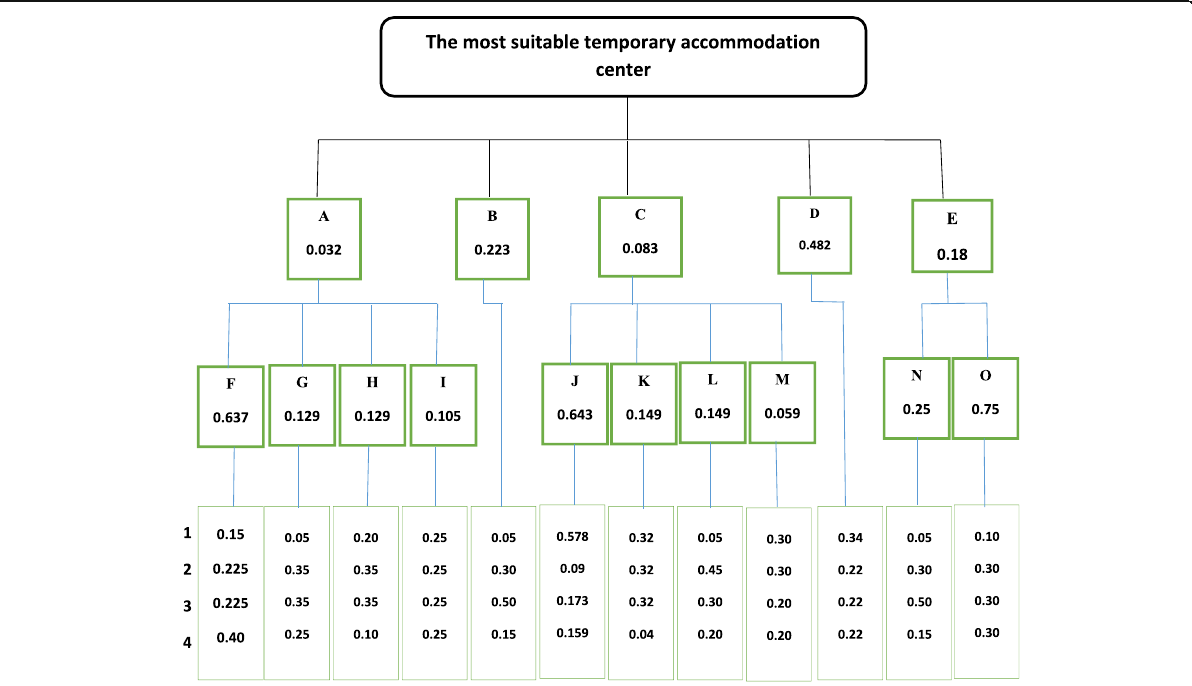
Fig. 14 Significance coefficients of the criteria, sub-criteria and choices in hierarchical